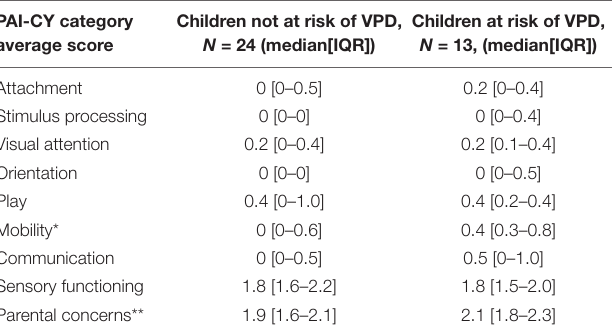
TABLE 6 | Results of the participation and activities inventory for children from 0 to 2 years (PAI-CY 0-2), separately for children not at risk and children at risk of VPD. PAI-CY category Children not at risk of VPD, Children at risk of VPD, average score N = 24 (median[IQR]) N = 13, (median[IQR])